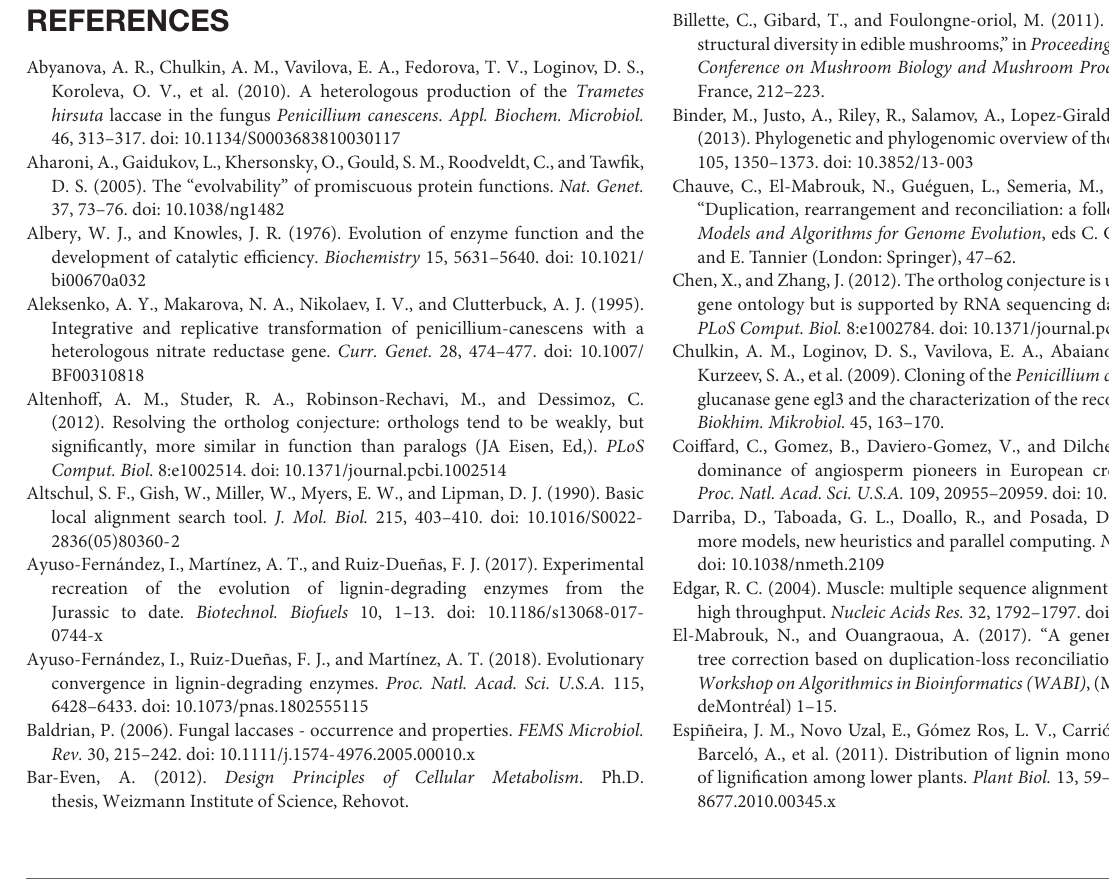
FIGURE S1 | The remainder of the laccase gene-tree. The following abbreviations are used: FomPin, F. pinicola; WolCoc, W. cocos; PhlChr, P. chrysocreas; PhlBre,